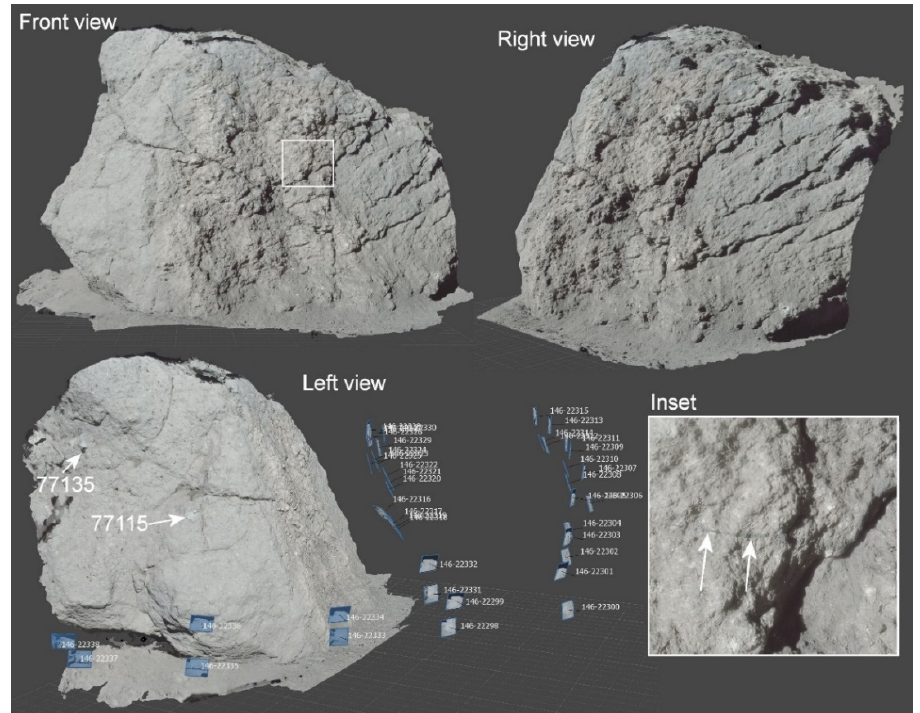
Figure 4. Photogrammetric reconstruction (textured 3-D model) of the 2-m-high boulder at Station 7. The position and orientation of the 41 entry Apollo images (AS17-146-22298 to AS17-146-22338) as computed by Metashape are indicated on the left perspective view (annotated squares), together with the location of samples 77135 and 77115. The inset shows a close-up of the area located in the white rectangle on the front view, to illustrate the level of details allowed by the 3-D reconstruction. Arrows point to a 3–5 cm vein.